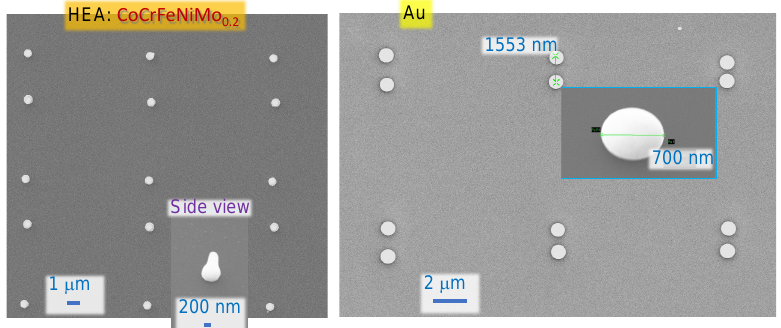
Figure 4. Arrays of microparticles made by LIFT of high CoCrFeNiMo 0.2 and Au transferred onto Si wafer at pulse energies E p = 344 nJ or 5.6 J/cm 2 (on sample) for HEA and 816 nJ or 14 J/cm 2 for Au under NA = 0.26 focusing. Laser irradiation: 230 fs, 515 nm. Thickness of HEA and Au was 50